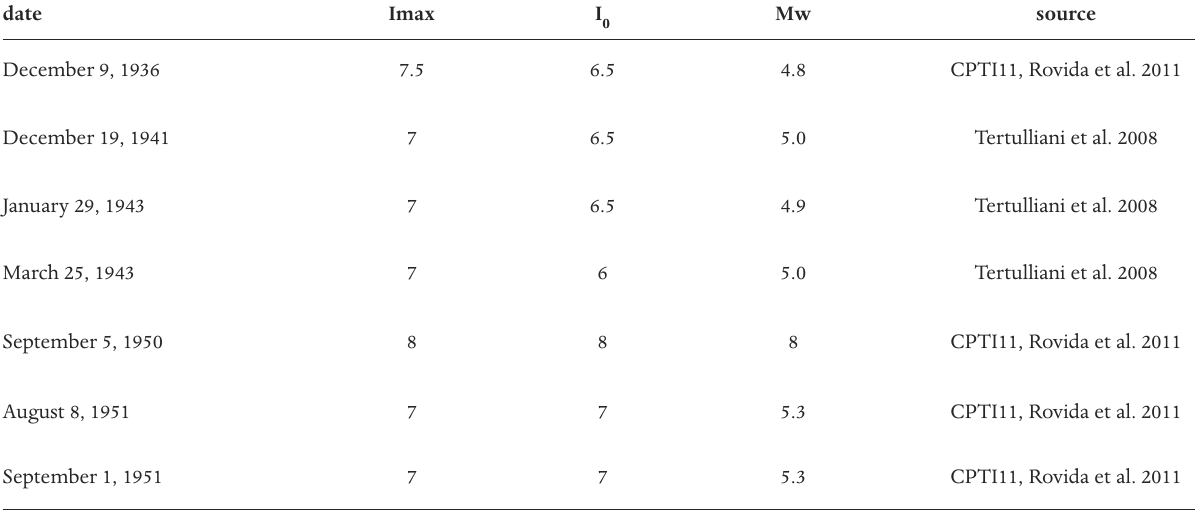
Table 1. List of the earthquakes occurred in the study area in a range of fifteen years around the 1943 event. The events are those in Figure 6. Maximum intensities, epicentral intensities and macroseismic magnitudes are indicated for each